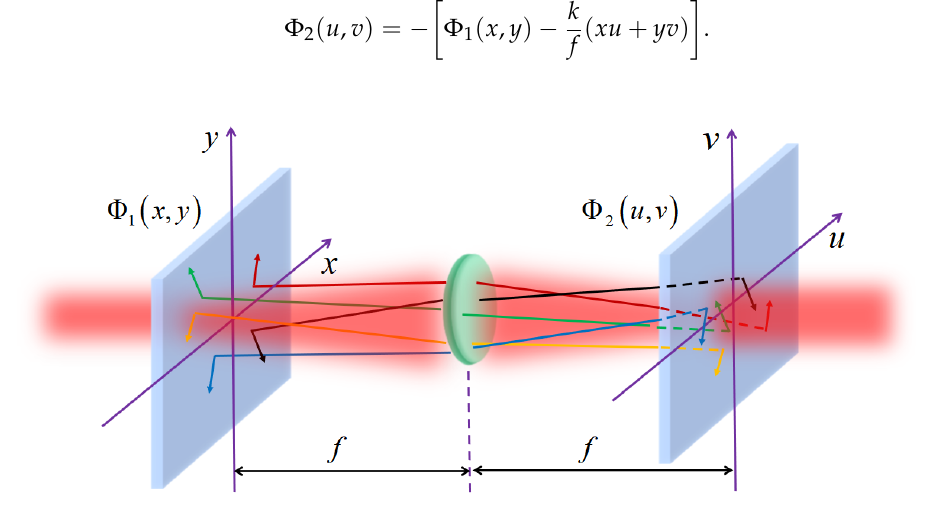
Figure 3. Illustration of optical coordinate transformation based on a single lens (transformation leaves the polarization state unchanged with point-to-point